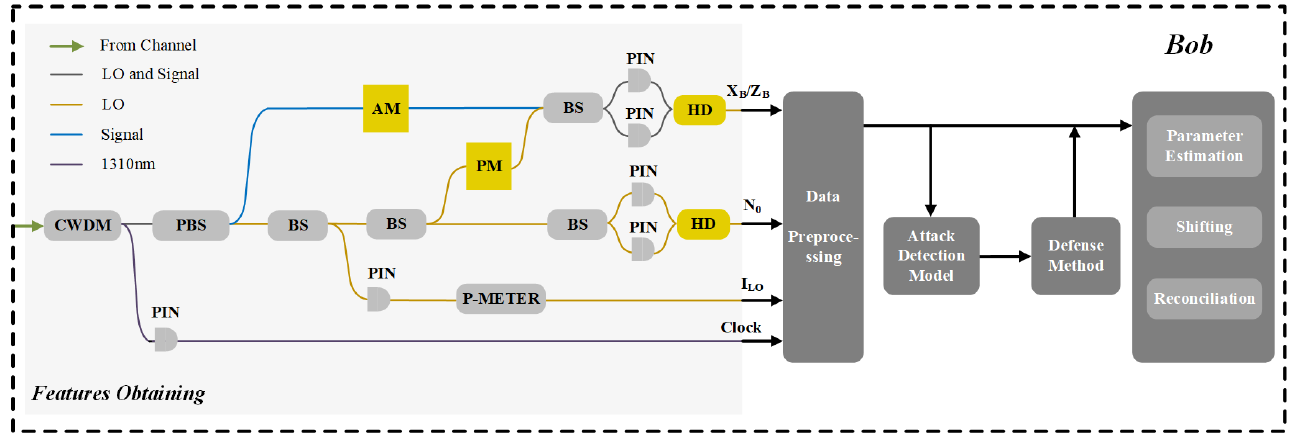
Figure 1. Schematic diagram of applying one-pixel attack in a CV-QKD system to deceive the attack detection portion. CWDM: coarse wavelength-division multiplexing. PBS: polarization beam splitter. AM: amplitude modulator. PM: phase modulator. PIN: PIN photodiode. HD: homodyne detector. P-METER: the power meter to monitor LO intensity. Clock: clock circuit used to generate clock signal for